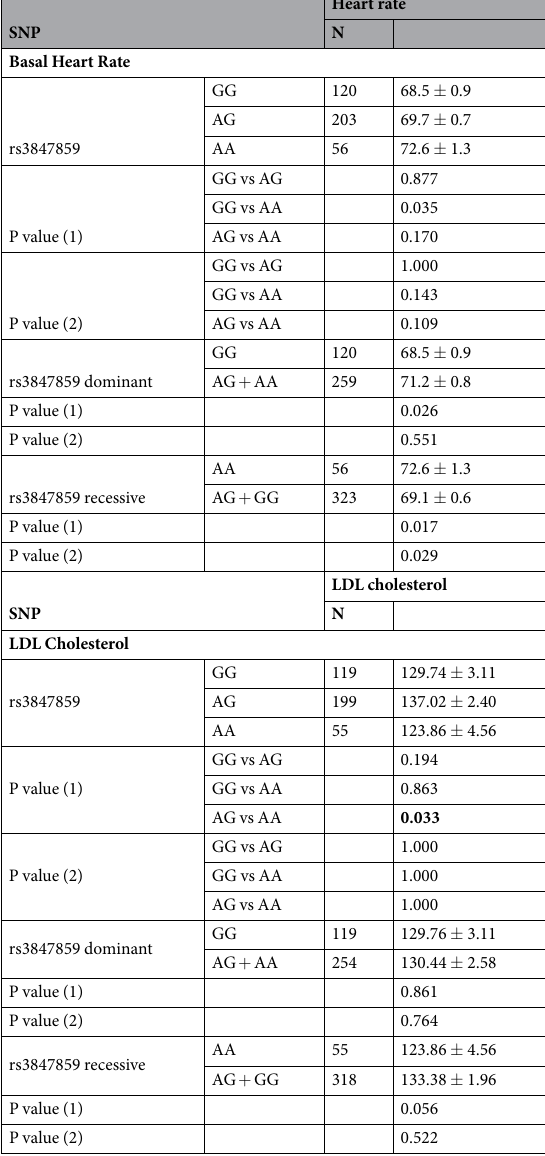
Table 6. Statistically significant results in the distribution of ALK1 rs3847859 polymorphisms according to basal heart rate and plasma LDL cholesterol. P value adjusted by sex and age (1) and by sex, age, DM, HTA, DL, tobacco, alcohol and BMI (2). SD: standard deviation; SNP: single nucleotide polymorphism. Statistically significant results in